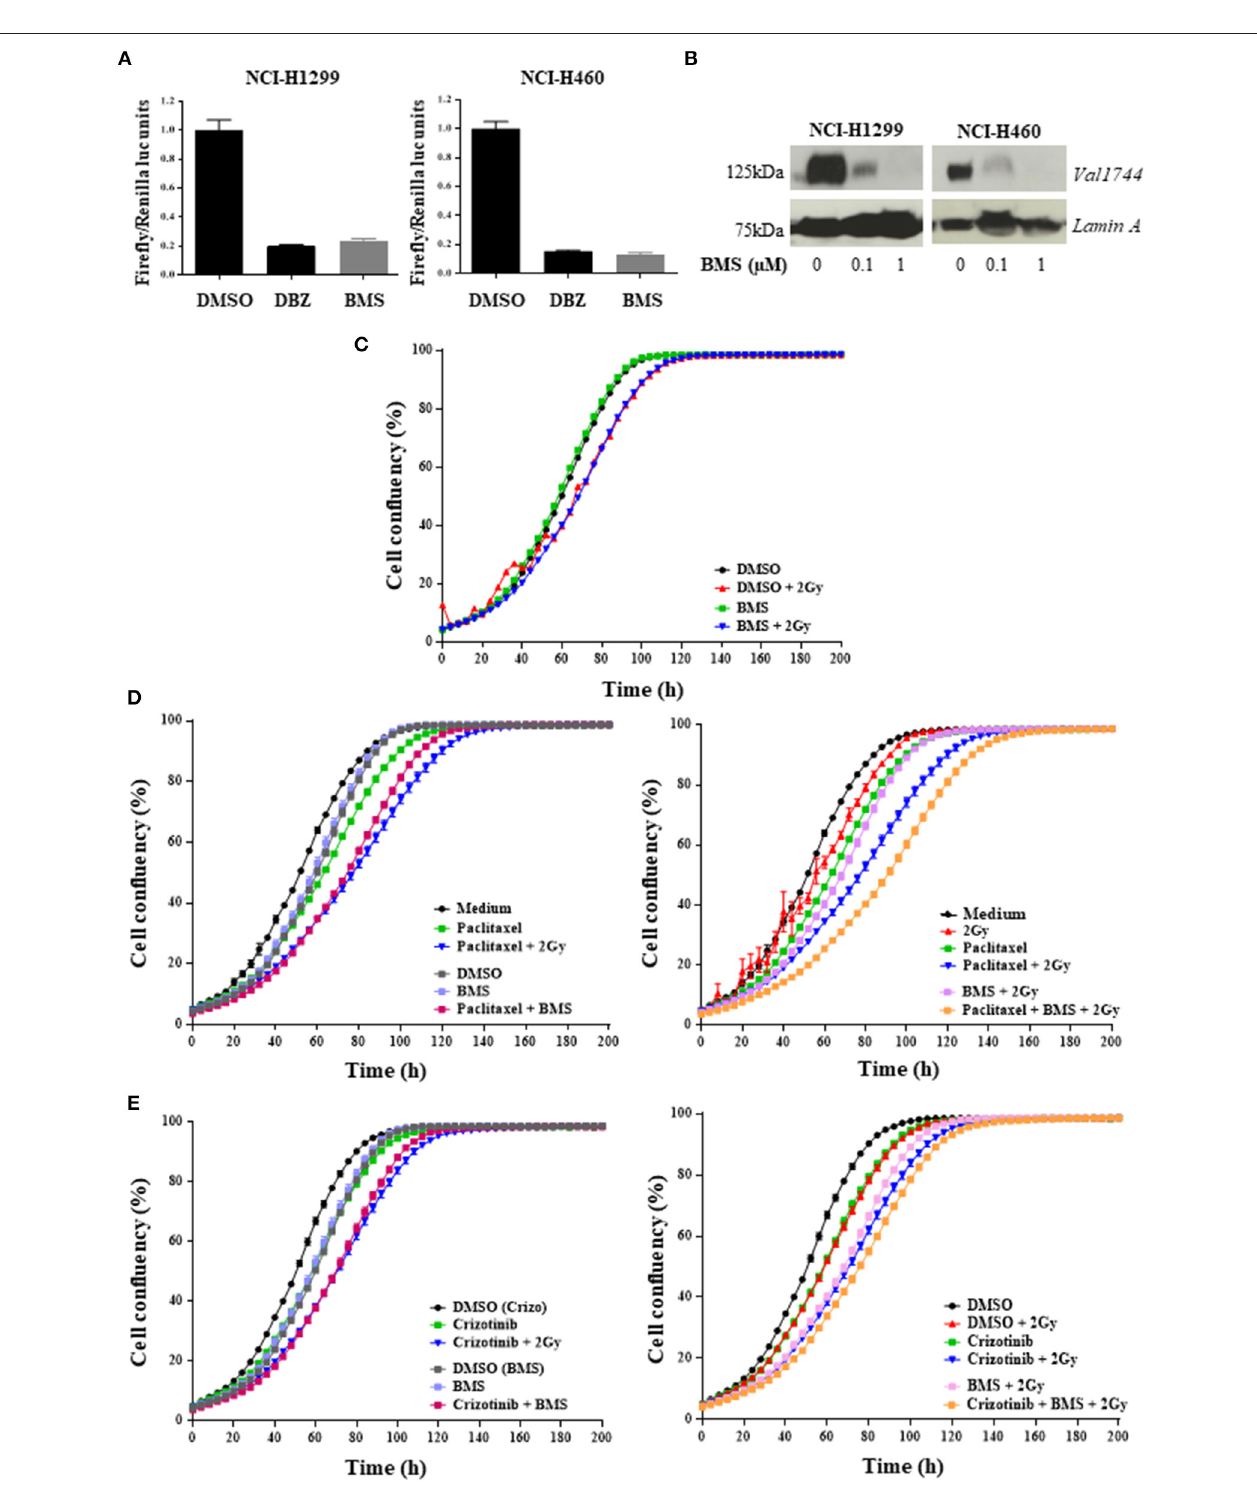
FIGURE 2 | Pan-NOTCH/ γ -secretase inhibitor BMS-906024 delays cell proliferation of H1299 cells treated with chemoradiation. Luciferase reporter assay (A) and Western Blot (B) of NCI-H1299 and NCI-H460 treated with DMSO (vehicle) or either 0.2 µ M dibenzazepine (DBZ), or 0.1 or 1 µ M BMS-906024. Incucyte analysis of cell confluency (%) over time of NCI-H1299 cell line for BMS-906024 1 µ M with/without 2 Gy radiation (C) ; 2.5nM paclitaxel (D) or 0.4 µ M crizotinib (E) compared to dual treatment including 1 µ M BMS-906024 (left) or comparing chemoradiation with 2Gy to triple combination including 1 µ M BMS-906024 (right). A minimum of two independent experiments and 6–18 wells/condition/experiment were tested. Mean and standard error of the mean are plotted.